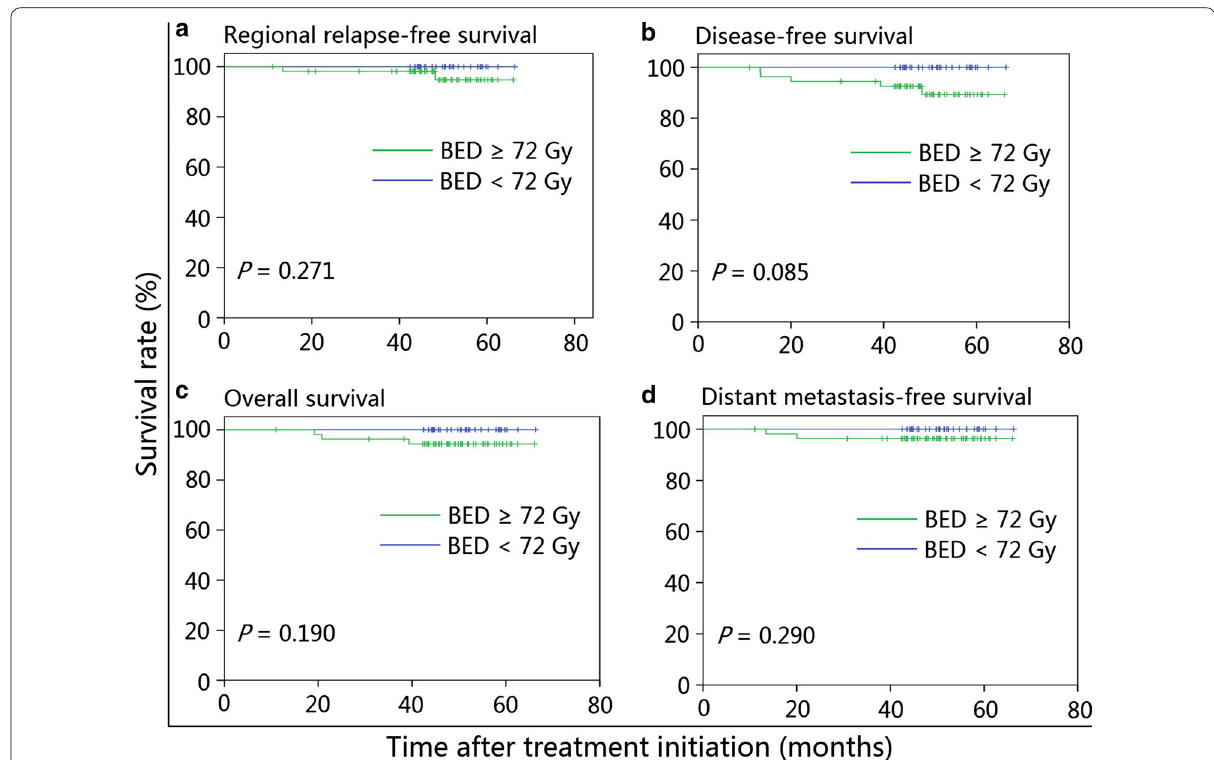
Fig. 3 Kaplan–Meier survival curves of N0‑category NPC patients in the small ENLN group stratified by a biological equivalent dose (BED) < or 72 Gy. a Regional relapse‑free survival; b disease‑free survival; c overall survival; d distant metastasis‑free survival. NPC nasopharyngeal ≥ carcinoma, ENLN enlarged neck lymph